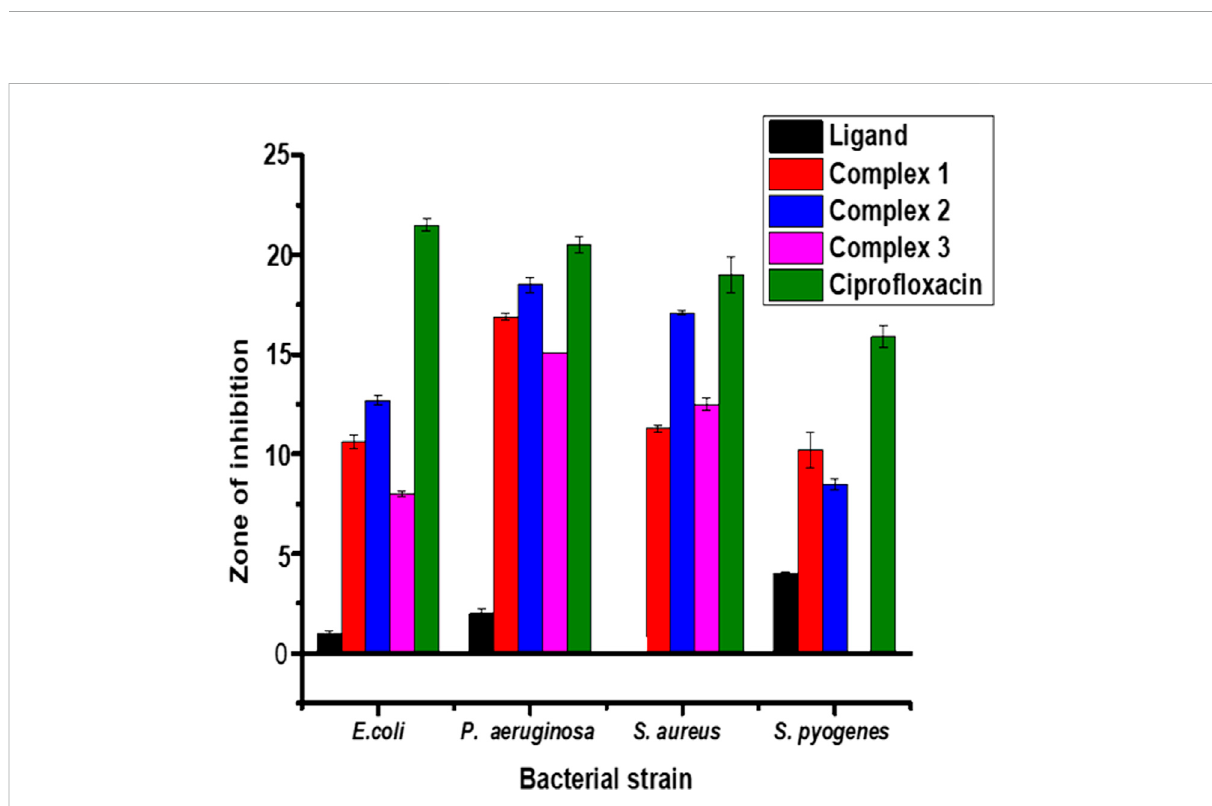
FIGURE 6 Antibacterial activity of the ligand and its Zn(II), Cu(II) and Ni(II) complexes at 150 μ g/ml. Error bars indicate standard